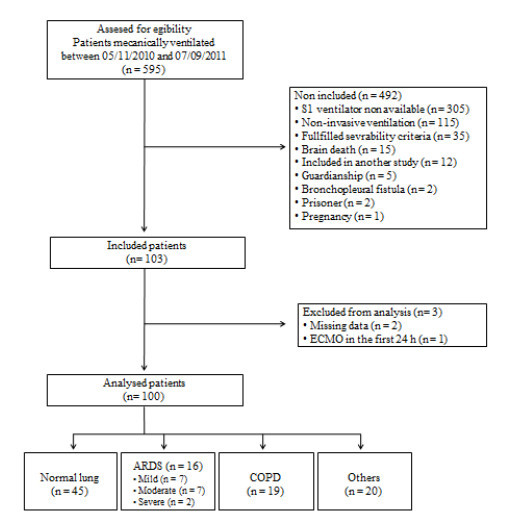
Study flow diagram.